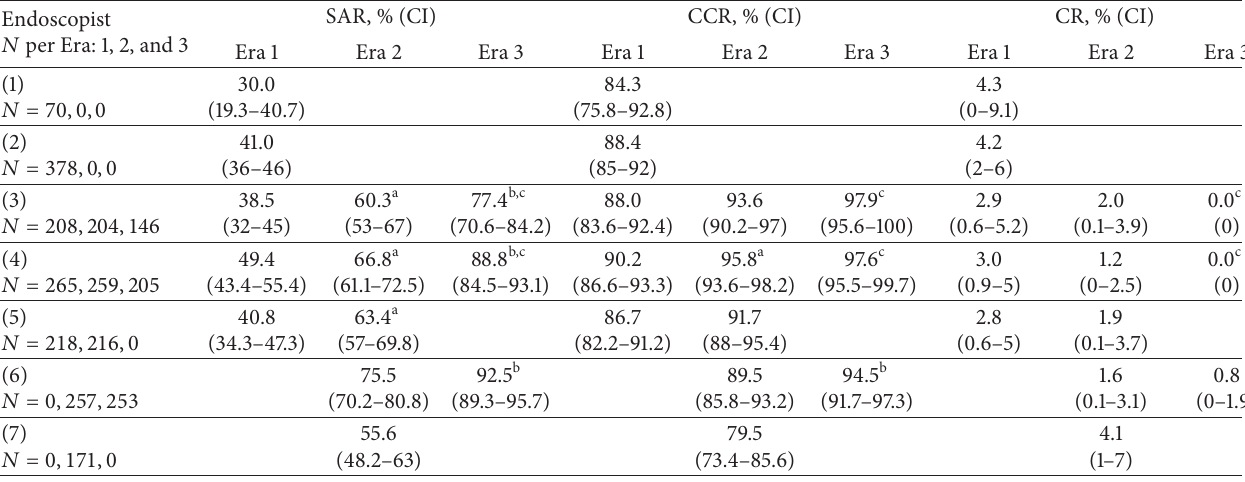
Table 2: Individual endoscopist performance in cohort